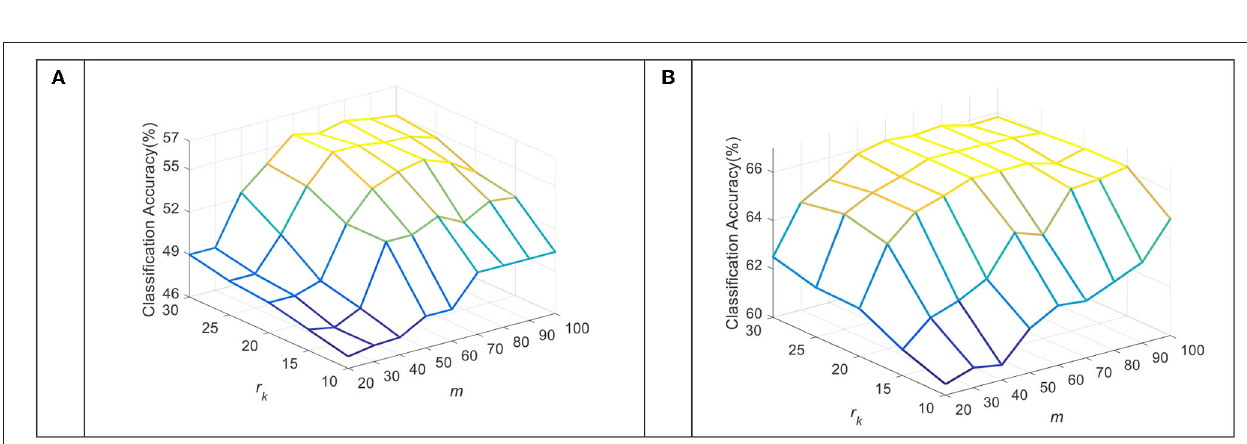
FIGURE 6 | The average classification accuracy of the TDDPL approach under varying m and r k on the SEED IV dataset. (A) o → o scenario, (B) m → o scenario.